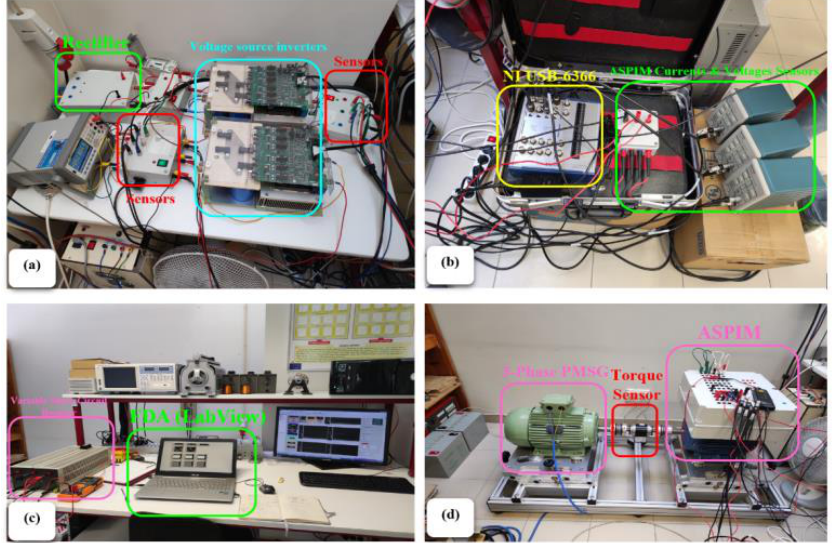
Figure 8. Experimental setup. (a) Voltage source inverters; (b) DAQ system; (c) Implementation of the fault detection algorithm in LabVIEW; (d) ASPIM. Table 1. Asymmetrical six-phase induction motor parameters.